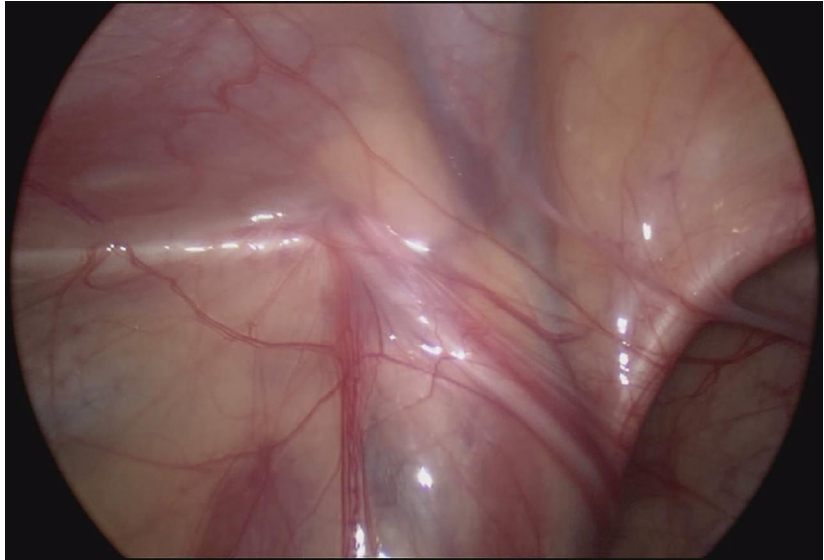
Figure 1. Deferent duct with hypoplastic “testicular” vessels entering the inguinal canal.